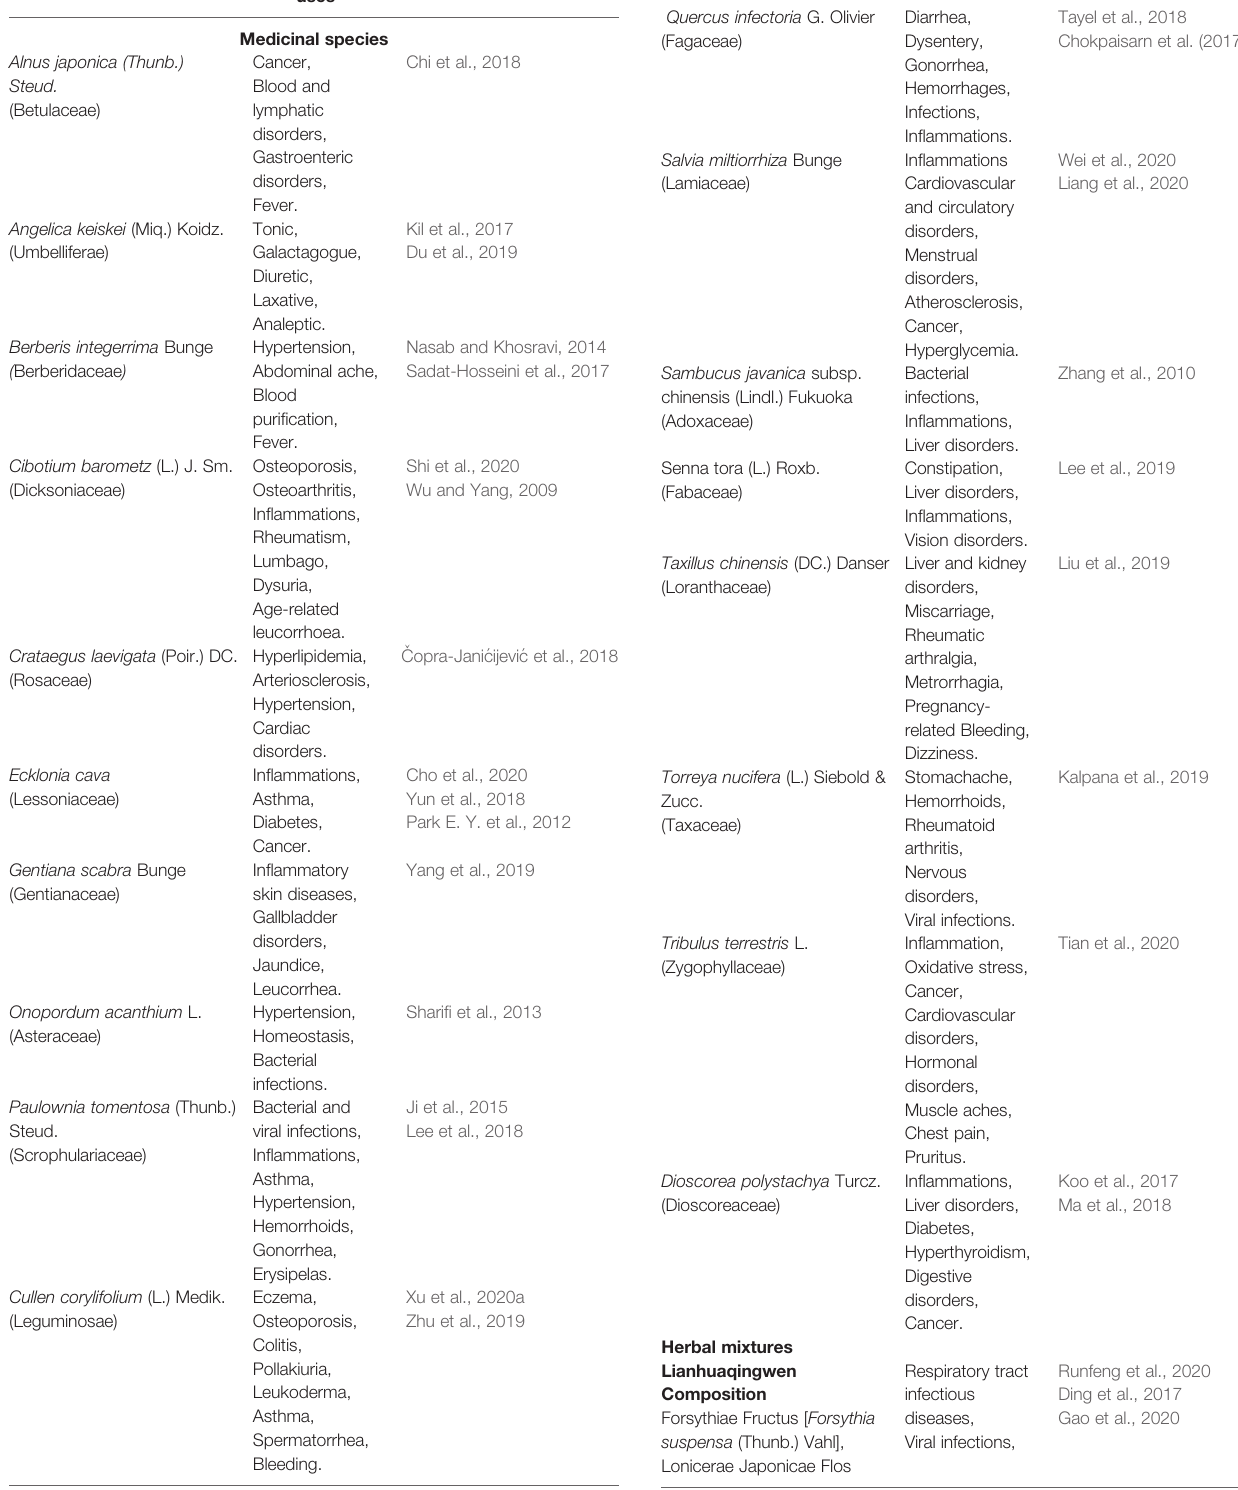
TABLE 2 | Traditional uses of the medicinal species and mixtures with possible anti-SARS-CoV-2 effects. Plant